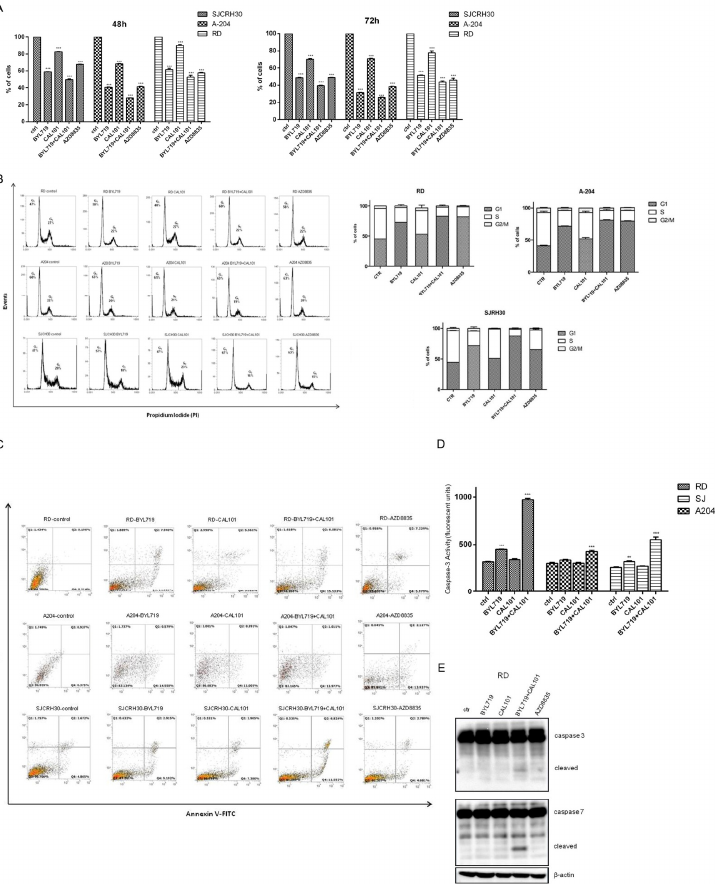
Figure 4. Combination of BYL-719 + CAL-101 arrests rhabdomyosarcoma cell cycle and induces caspase-dependent apoptosis. ( A ) RD, SJCRH30, and A204 cells were seeded in a 6-well plate at a concentration of 2 × 10 5 cells/well. Cells were treated with 5 µ M of either Alpelisib (BYL-719), Idelalisib (CAL-101), AZD8835 or BYL-719 + CAL-101 (2.5 µ M + 2.5 µ M), or left untreated. After 24, 48, and 72 h, cells were collected and counted. Cell viability was assessed by trypan blue exclusion. Histograms show the percentage of viable cells and are representative of three independent experiments. *** p < 0.001. ( B ) Cell cycle analysis of RD, A204 and SJCRH30 cells treated with 5 µ M of either BYL-719, CAL-101, AZD8835 or BYL-719 + CAL-101 (2.5 µ M + 2.5 µ M), or left untreated for 72 h. RD, SJCRH30, and A204 were seeded at the concentration of 1 × 10 6 cells/well; after 24 h, cells were treated as described above, stained with propidium iodide (PI) and subjected to FACS analysis. Histograms show the percent distribution of cells in each of the cell cycle phases and are representative of three independent experiments. ( C ) RD, SJCRH30, and A204 were seeded at the concentration of 1 × 10 6 cells in 100 mm plates. After an overnight incubation, cells were treated with 5 µ M of either BYL-719, CAL101, AZD8835, or BYL-719 + CAL101 (2.5 µ M + 2.5 µ M), or left untreated, for 24 h. Cells were then stained with Annexin V-FITC/PI and flow cytometry analysis was carried-out to evaluate the induction of apoptosis. Q1 quadrant (FITC − /PI + ); Q2 quadrant (FITC + /PI + ); Q3 quadrant (FITC − /PI − ); Q4 quadrant (FITC + /PI − ). ( D ) Caspase-3 activity assay in RD, A204 and SJCRH30 cells, treated with 5 µ M of either BYL-719, CAL-101 or BYL-719 + CAL-101 (2.5 µ M + 2.5 µ M), or left untreated for 48 h. Fifty (50) µ g of protein lysate for each experimental point was used in the analysis of endogenous caspase-3 activity. Samples were analyzed in triplicate and data are representative of the combined biological experiments. ** p < 0.01; *** p < 0.001. ( E ) Western blot analysis of RD cells to detect the activation of caspase-3 and caspase-7 after treatment with 5 µ M of either BYL-719, CAL-101, BYL-719 + CAL-101 (2.5 µ M + 2.5 µ M) or AZD8835 for 72 h; 60 µ g of protein was blotted in each lane. Antibody to β -actin served as a loading